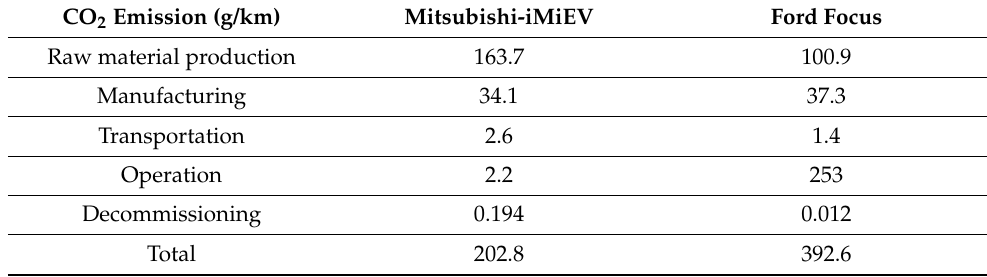
Table 7. A comparison of CO 2 emissions from the manufacturing and operation of an EV versus a petrol car.